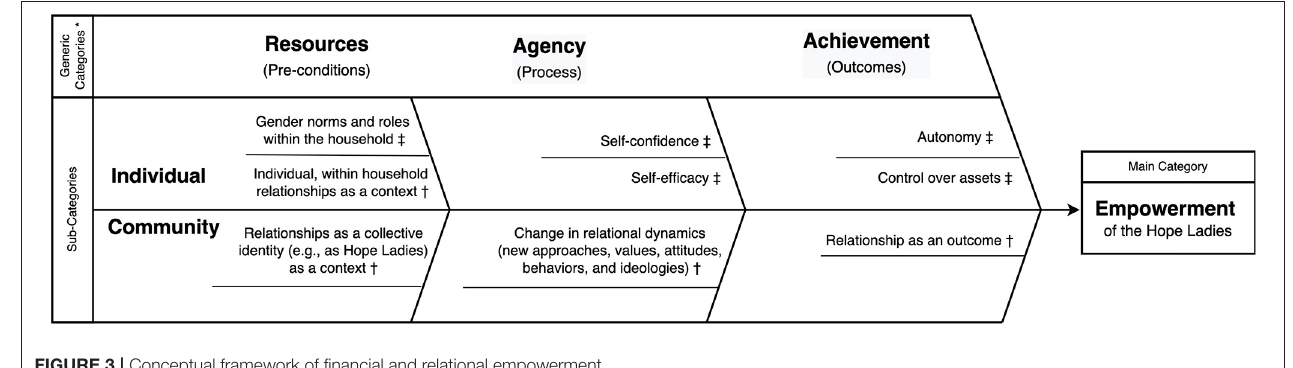
FIGURE 3 | Conceptual framework of financial and relational empowerment. *, Constructs from Kabeer’s conceptual framework of empowerment. † , Pre-determined codes about the Hope Ladies’ relational empowerment, derived from Relational Leadership Theory. ‡, Pre-determined codes about the Hope Ladies’ economic empowerment, derived from International Center for Research on